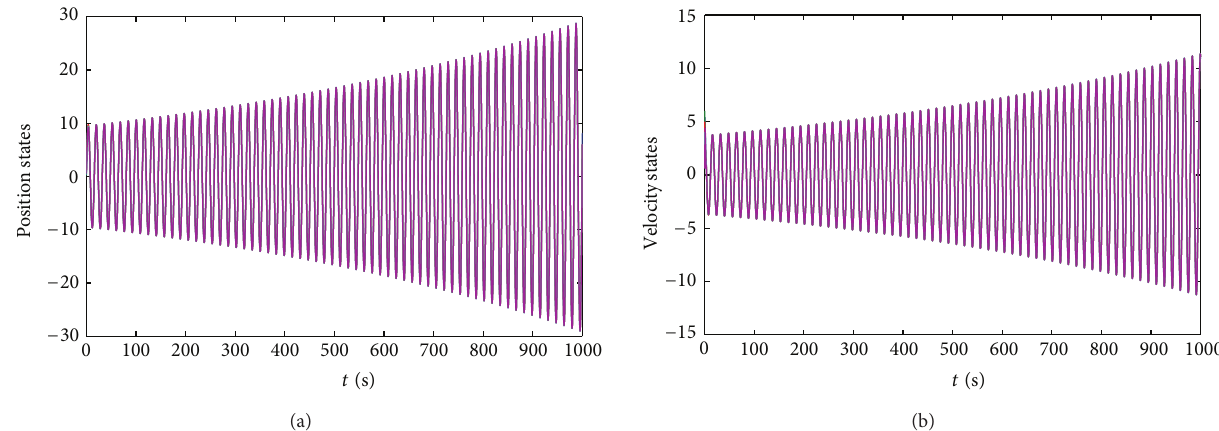
Figure 3: Velocity and position states of five agents in a network under periodic consensus protocols where 𝜏 = 0.394 > 𝜏 0